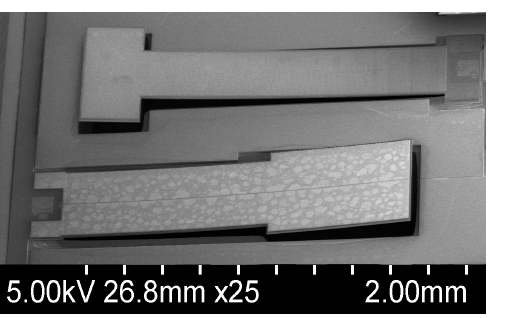
Table 3. Fabricated Design Parameters.